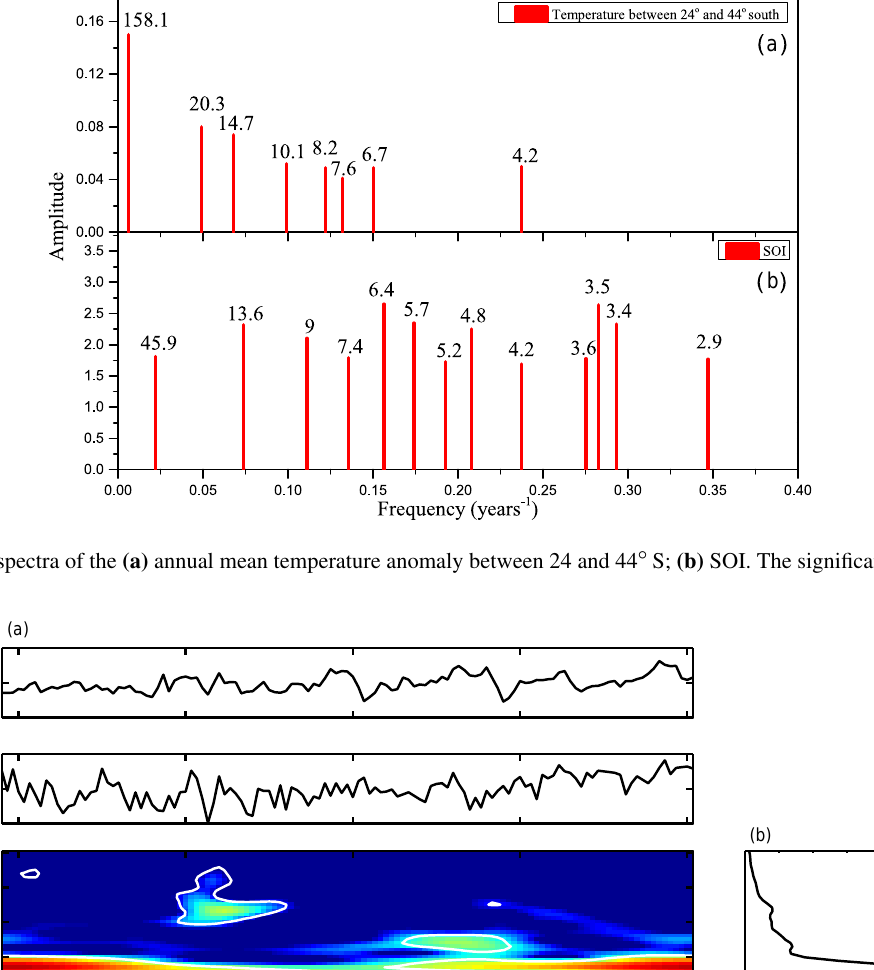
sunspot number which corresponds to the red line and